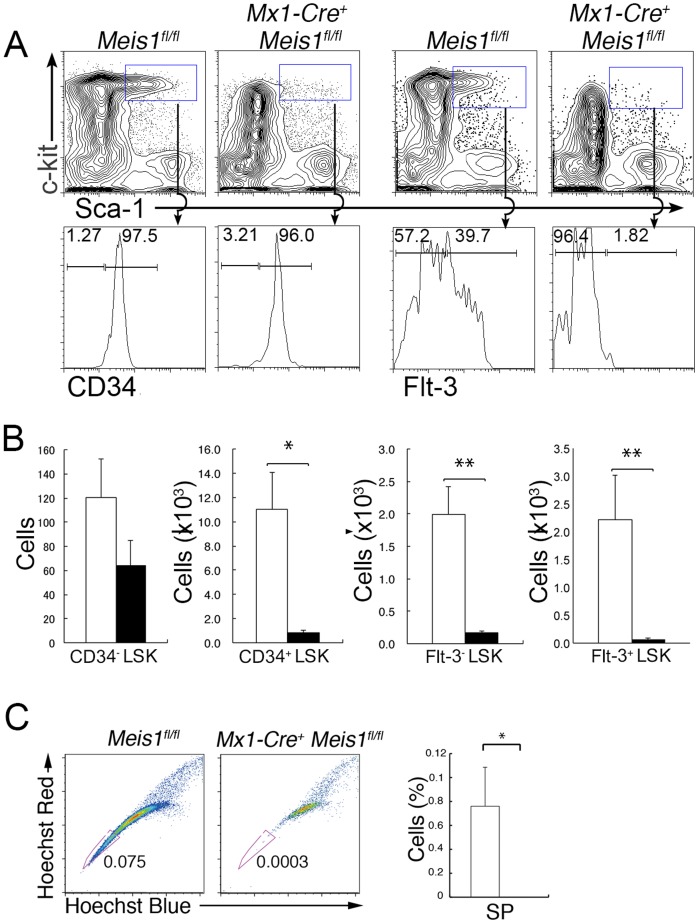
Loss of Meis1 causes profound defects in the HSC compartment.(A) Representative flow cytometric profiles of LSK cells in BM depleted of lineage-positive cells from Mx1-Cre
+
Meis1
fl/fl and control Meis1
fl/fl mice three weeks after poly(I:C) treatment. Gates used to identify LSK cell populations are outlined, and downward arrows indicate their relationship to subsequent histograms showing the expression of CD34 or Flt3 in these cell populations. Numbers in the histograms indicate percent events in each gate. (B) Absolute numbers of the indicated LSK cell populations per two femurs from poly(I:C)–treated Mx1-Cre+ Meis1
fl/fl (solid bars) and control Meis1
fl/fl (open bars) mice (mean and SD; n = 4). *p<0.05 and **p<0.01. (C) Representative flow cytometric profiles of side population (SP) cells within the LSK population from Mx1-Cre
+
Meis1
fl/fl and control mice one week after poly(I:C) treatment. Bar graphs shown on the right represent the percentage of SP cells in the LSK cell population from poly(I:C)–treated Mx1-Cre
+
Meis1
fl/fl (solid bars) and control Meis1
fl/fl (open bars) mice (mean and SD; n = 3). *p<0.005.